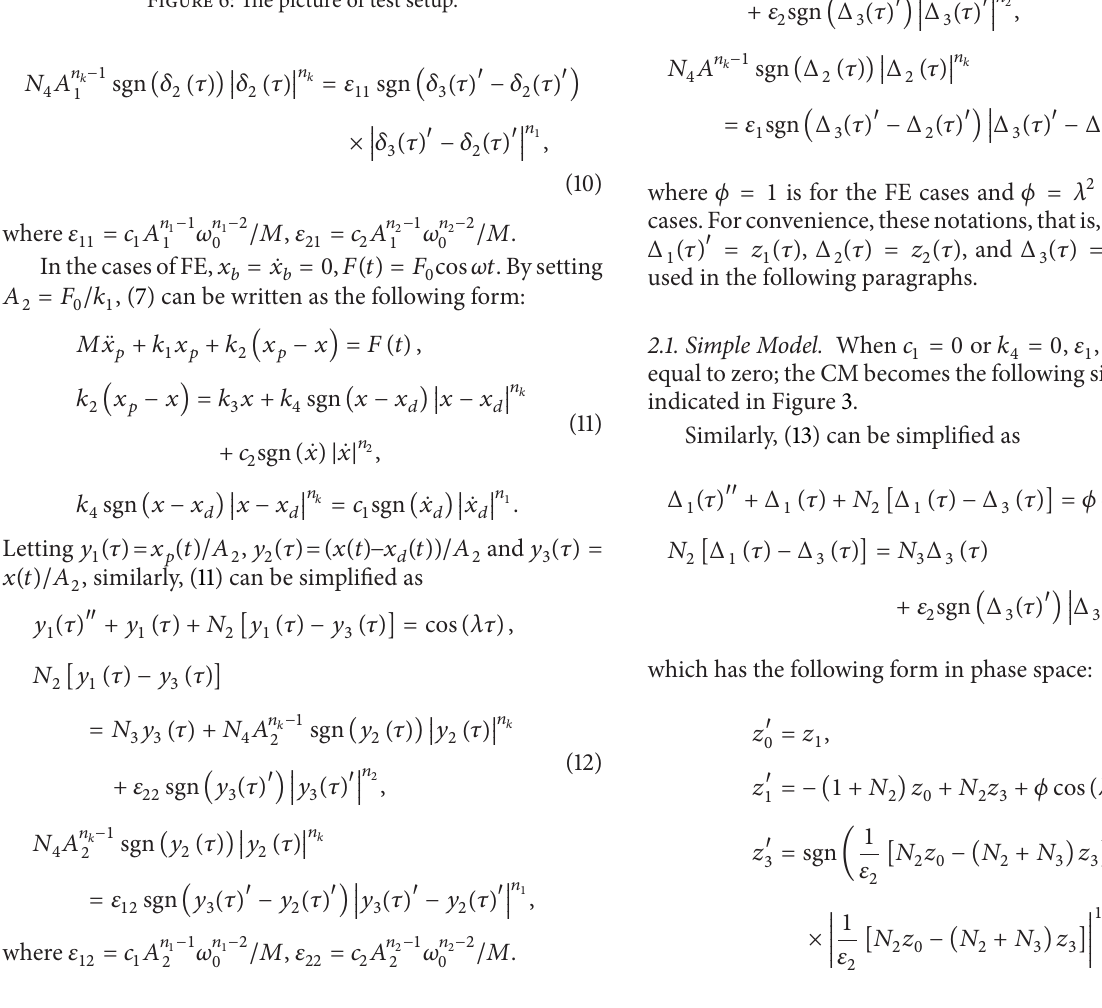
Figure 6: The picture of test setup.